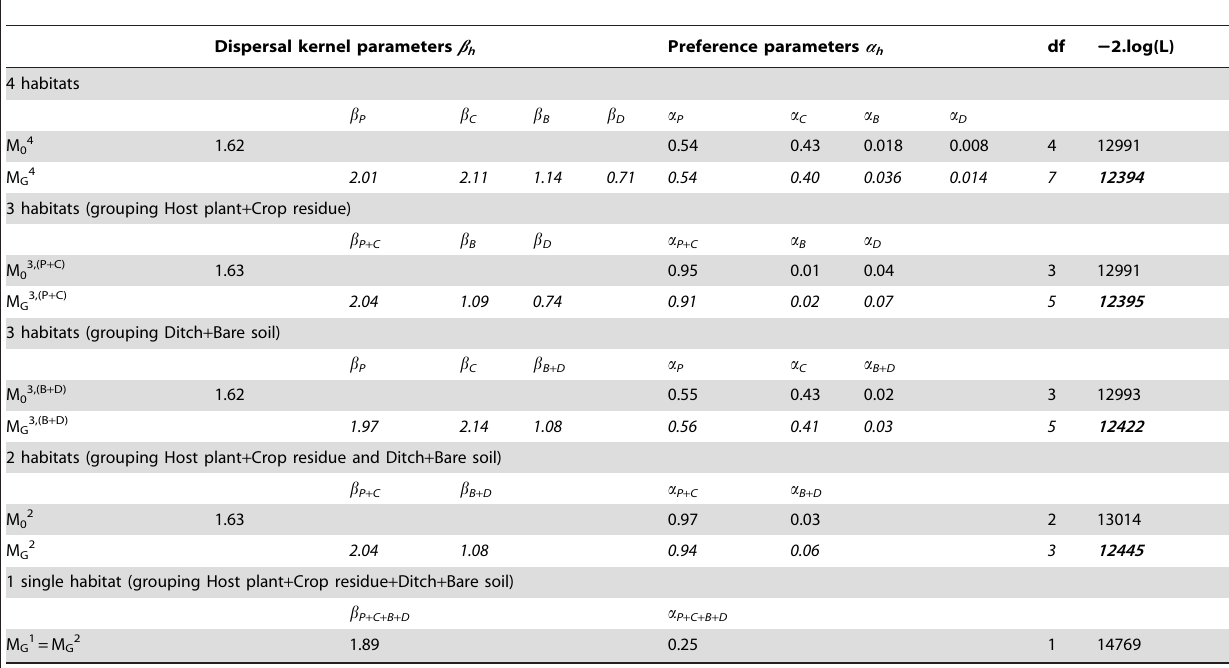
Table 1. Modified log-likelihood [ 2 2log(L)] and parameter estimates for the different